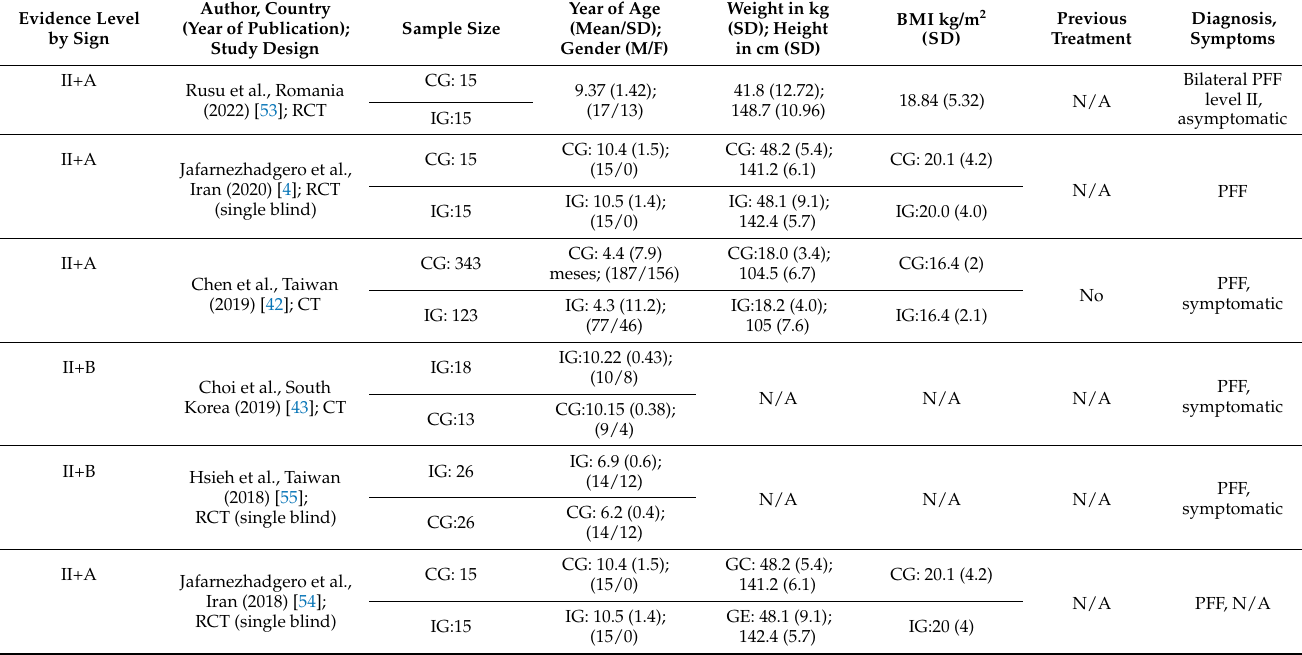
Table 1. Study characteristics and publication characteristics.